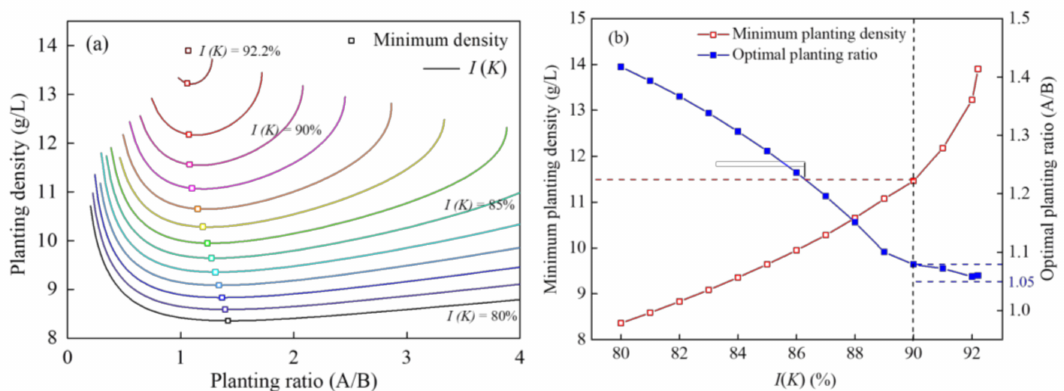
Figure 4. Relationship between the ( a ) planting ratio (A / B) and planting density and ( b ) optimal planting ratio and minimum planting density of two plants with a change in I ( K ).